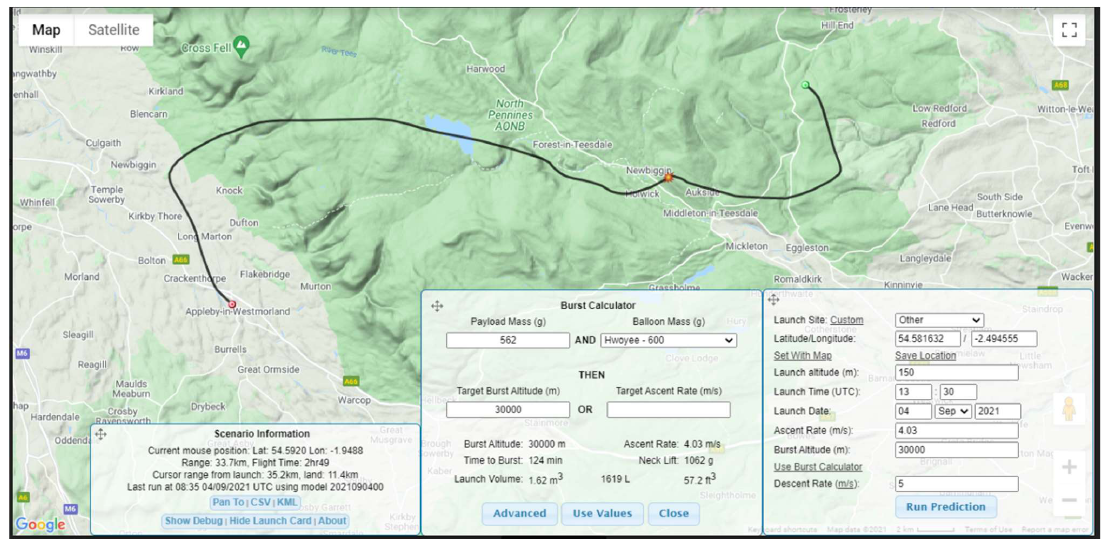
Figure 25. Typical flight plan with data used for prediction (Cambridge University planner).